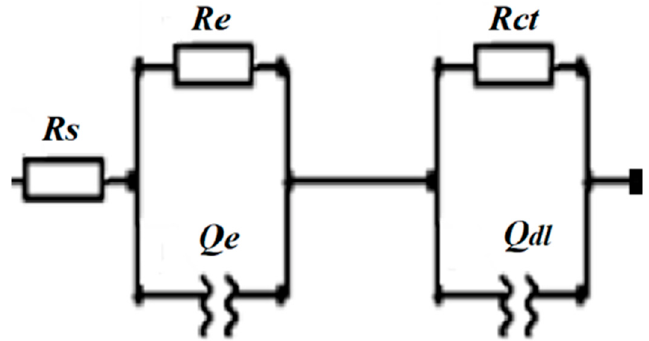
CoMo Co Ni The EIS measurements were used for additional investigation of the coating/electrolyte The EIS measurements were used for additional investigation of the coating/electro- interface and the related processes occurring at the coating surface under HER conditions in 1 M KOH. Figure 2C shows the Nyquist and Bode (inset) plots of the five coatings. The solution resistance ( R s ) (2.48–3.20 Ω range), as well as the charge transfer resistance ( R ct ) (1.08–2.80 Ω range), were calculated using the equivalent circuit presented in Scheme 1 and found to be comparable for the studied coatings (Table 4).